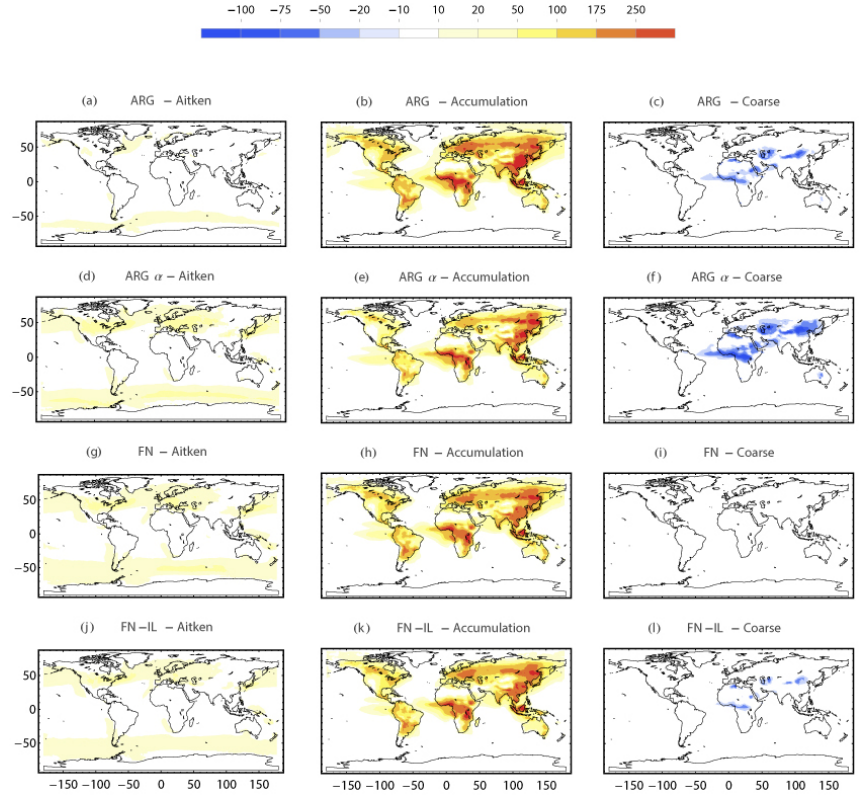
Fig. 3. Same as Fig. 2 but for aerosol hygroscopicity ∂N d /∂κ a